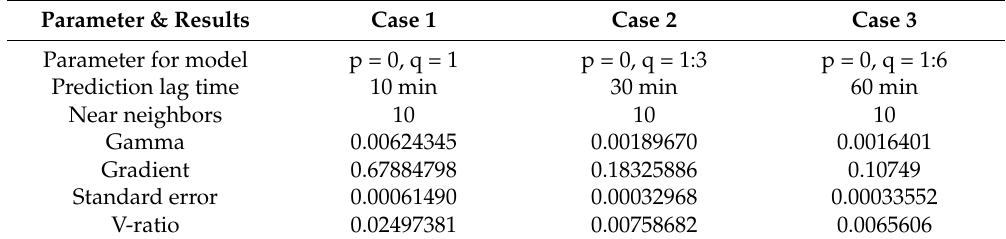
Table 1. Gamma test results for various prediction lag times.